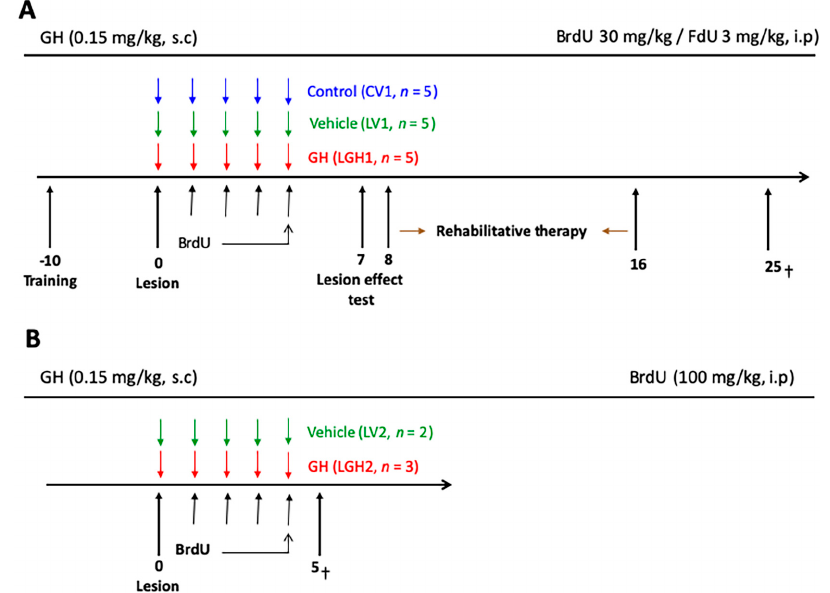
Figure 11. Schematic diagram of the experimental design. ( A ) The treatment with GH or vehicle started immediately after the lesion (LGH1 and LV1 groups, respectively). Sham-operated controls were treated with vehicle (CV1). The injections of BrdU / FdU commenced on day 1. On day 7 after lesion, the e ff ectiveness of the cortical ablation was evaluated in the paw reaching test. The rehabilitative therapy consisted in daily sessions of 3 min, with the obliged use of the impaired paw, for nine consecutive days. Animals were sacrificed at day 25 after lesion. ( B ) Diagram of the experimental design of animals treated with GH or vehicle and sacrificed at day 5 after injury. Day 0 indicates the day of the cortical ablation. Time scale